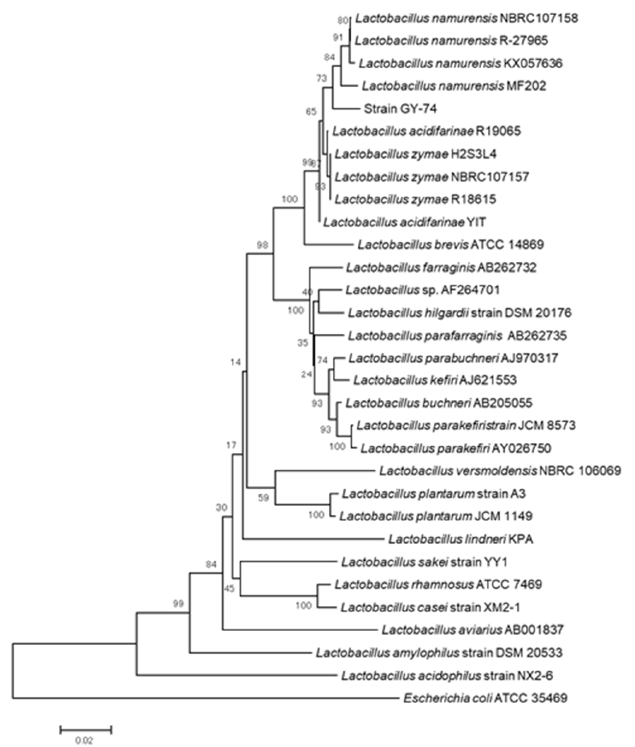
Figure 1. Phylogenetic tree was constructed by the neighbor-joining method based on the partial sequence of the 16S rRNA gene of strain GYP-74 and corresponding region in those for the authentic bacterial genes. Numbers at branches denote the bootstrap percentages of 1000 replicates. The scale at the bottom indicates the evolutionary distance of nucleotide substitutions per site.